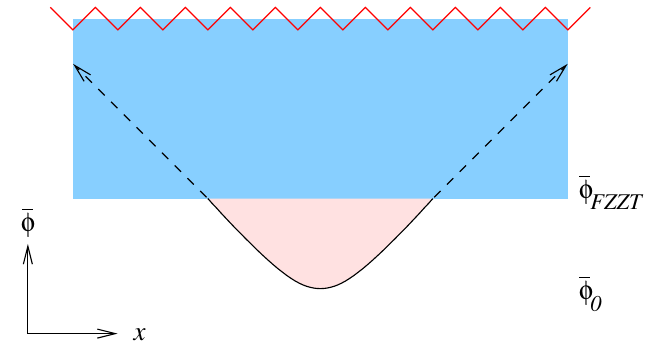
Figure 3. Schematic illustration of timelike FZZT branes and the folded strings with − 1 < ¯ b < 0 . The blue shaded region describes the FZZT-brane. For these values of ¯ b , the negative energy open string states (indicated by dotted arrow) propagate in the region where the Liouville potential is small (and the string coupling is